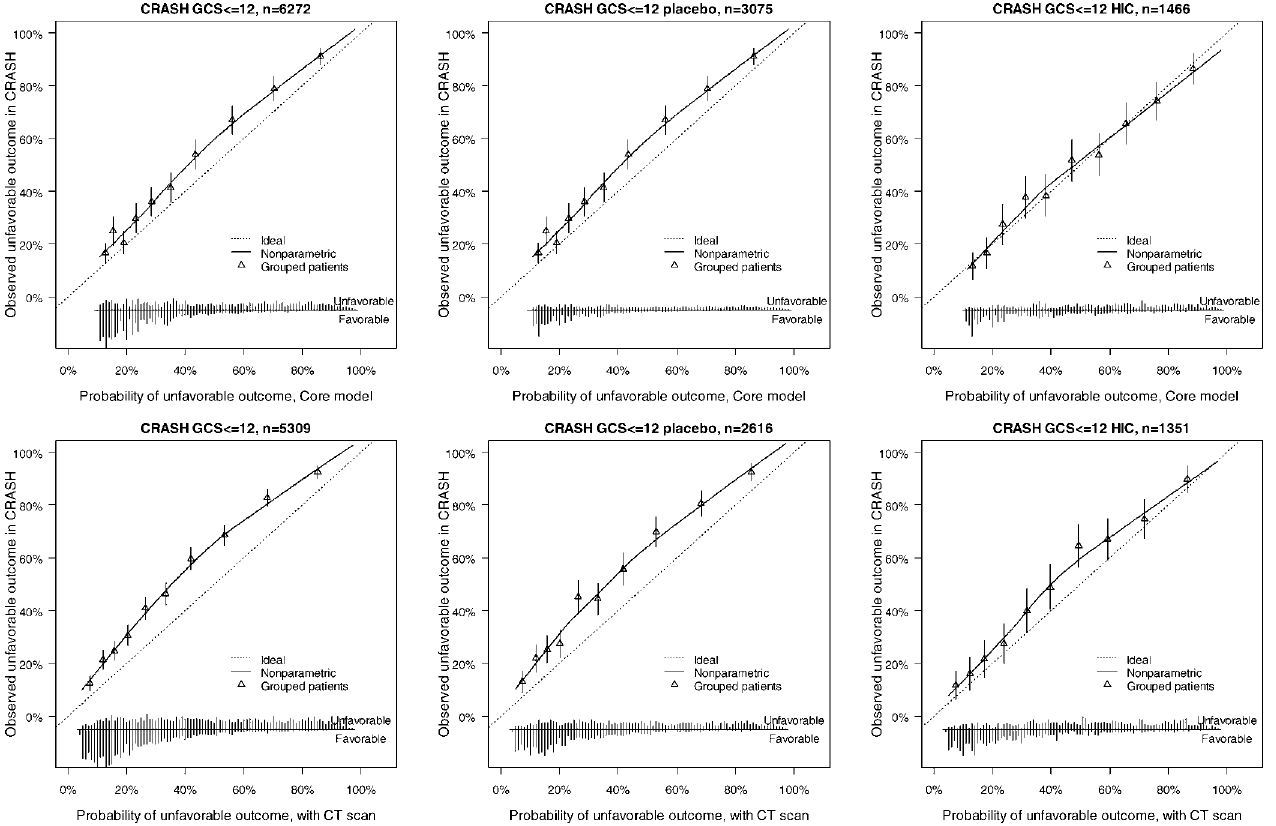
Figure 5. External Validity for the Core and Core þ CT Model Characteristics for Prediction of Unfavorable Outcomes in the CRASH Trial The distribution of predicted probabilities is shown at the bottom of the graphs, by 6-mo outcome. The triangles indicate the observed frequencies by decile of predicted probability.